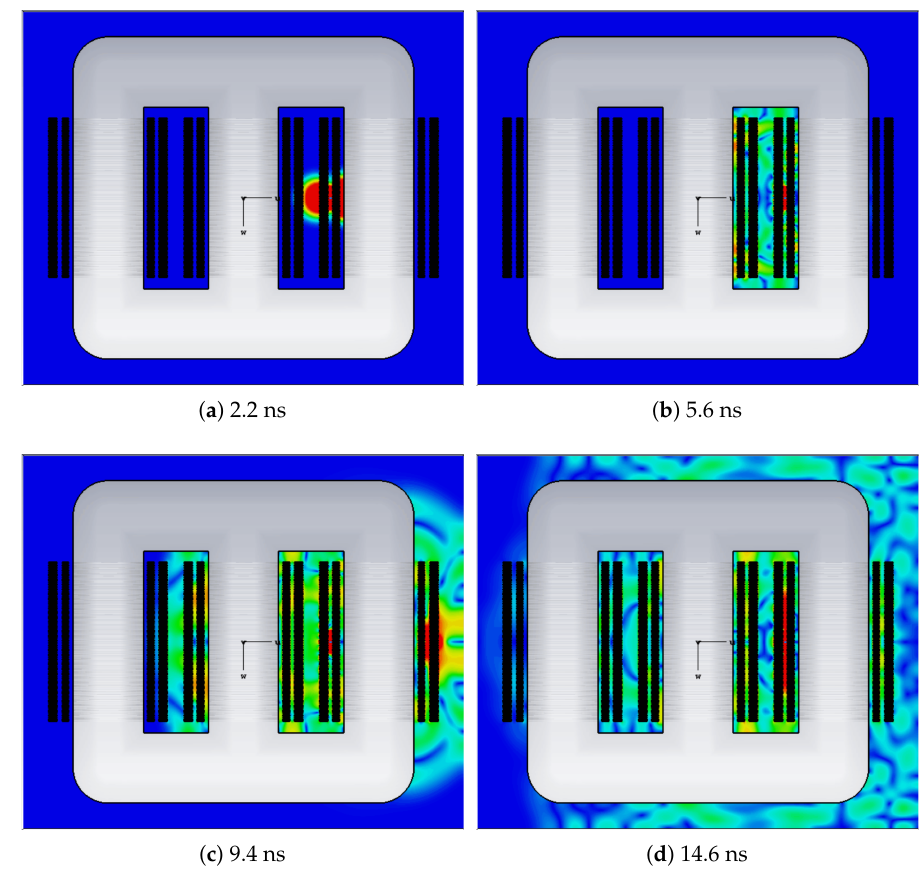
Figure 1. Radiation of electromagnetic waves in a power